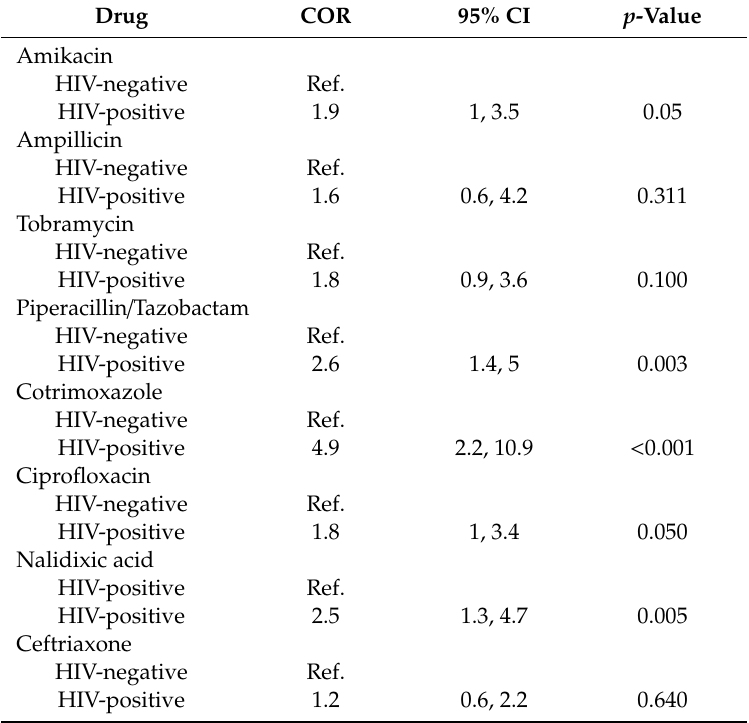
Table 2. Simple Logistic Regression Models of Drug Resistance by Human Immunodeficiency Virus (HIV) Status. Drug COR 95% CI p -Value